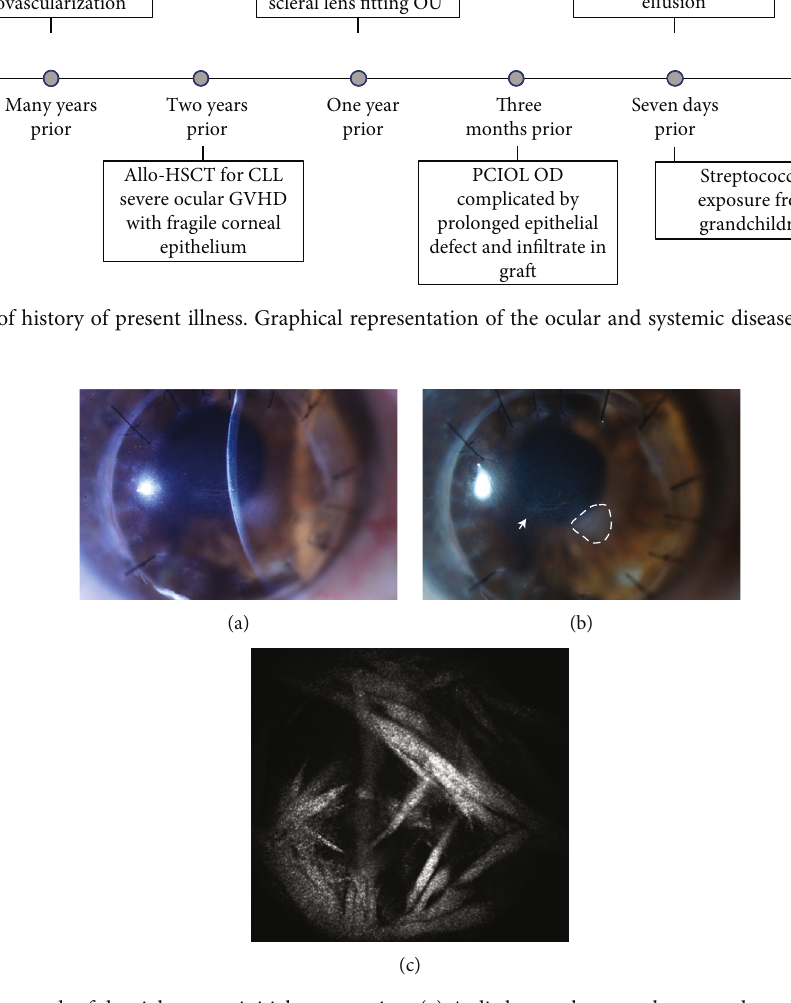
Figure 2: Slit-lamp photograph of the right eye at initial presentation. (a) A slit-beam photograph centered over the new crystalline pattern of branching thin structures in the anterior stroma. (b) A wide-beam photograph demonstrating the branch-like structures in the anterior stroma of the central visual axis (arrowhead), and nasally, a preexisting triangular anterior stromal scar (dashed outline). (c) Confocal microscopy revealed mid-stromal (195 μ m deep) highly re fl ective needle-like structures consistent with crystalline keratopathy, but not speci fi c for an individual